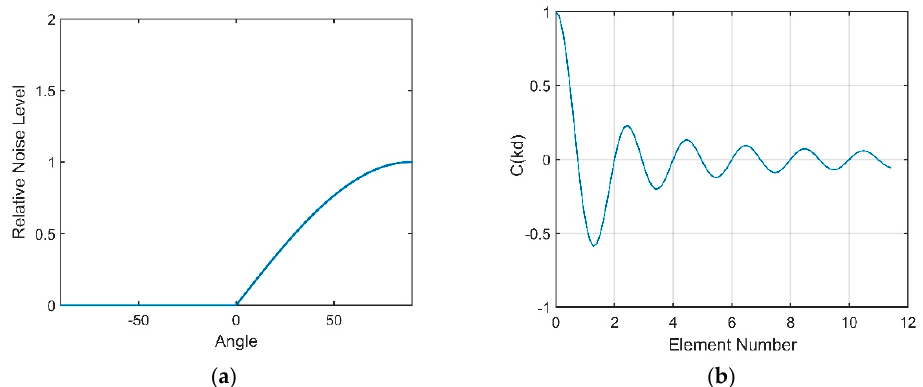
Figure 16. ( a ) Vertical directional density of the wind-driven noise at the frequency of 350 Hz; ( b ) Vertical correlation coefficient of the wind-driven noise at the frequency of 350 Hz.